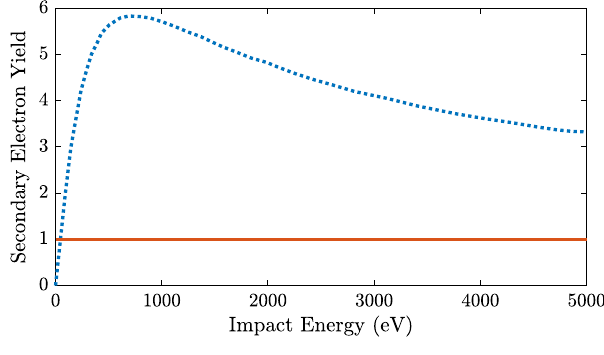
FIG. 4. Secondary emission yield of Cs 3 Sb.